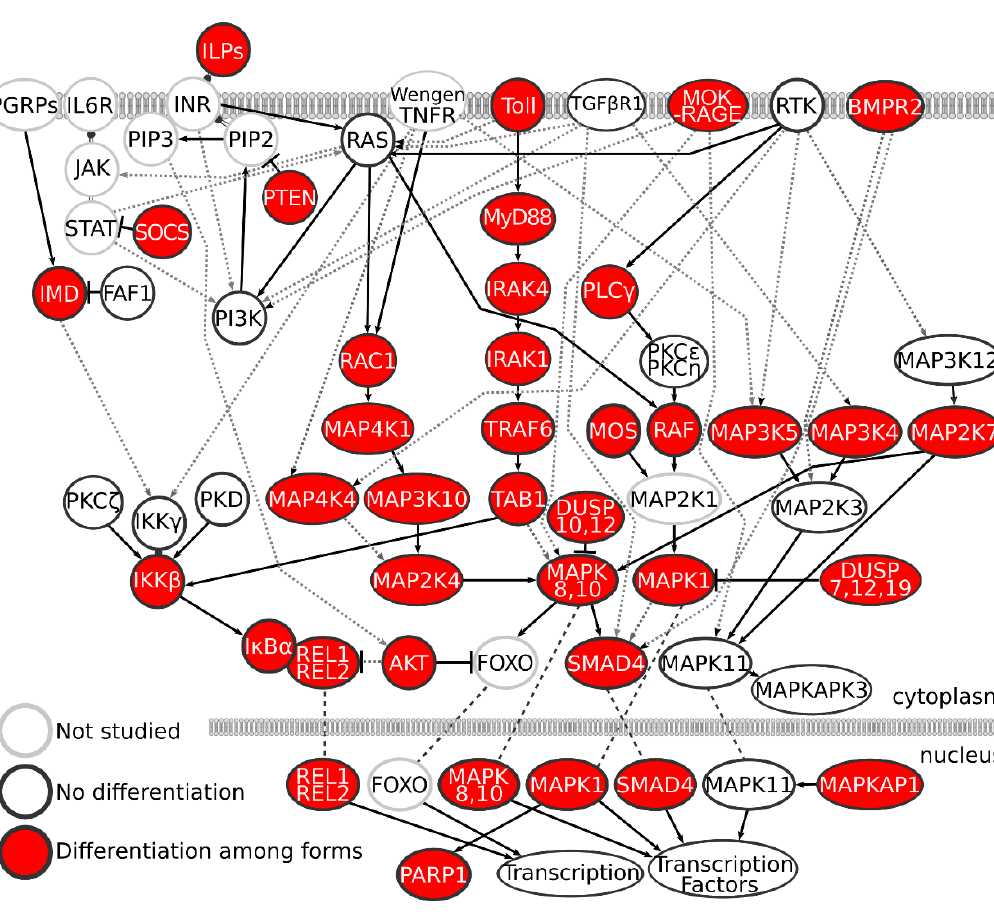
Figure 2. A diagram of immune signaling proteins encoded by genes used for this population-scale SNP genotyping study. Genes that are significantly diverged among the three taxa are in red-filled circles. Black outlined, open circles represent genes with no significant differentiation. Genes in gray outlined, open circles are represented in the pathways but were not included in genotyping. Solid lines indicate direct interactions. Dashed lines indicate indirect activation.